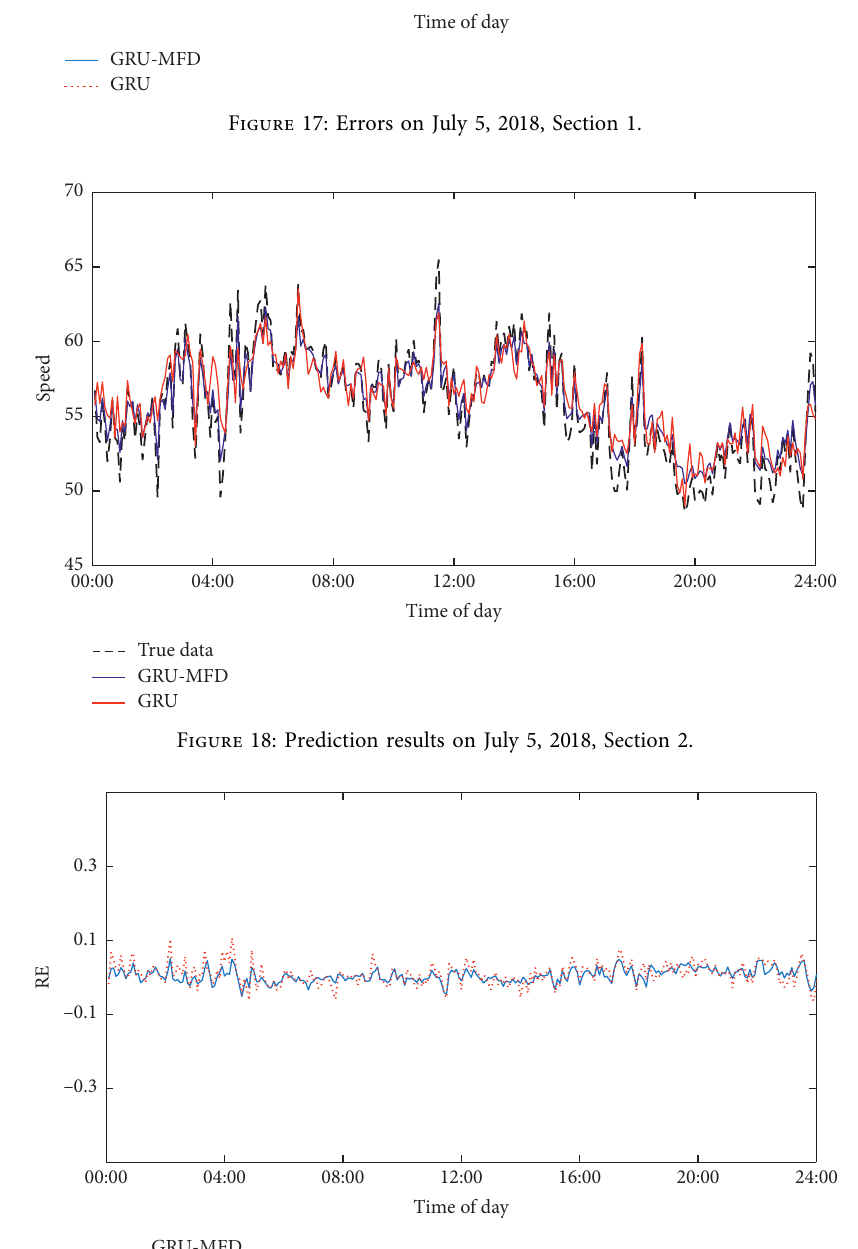
Figure 19: Errors on July 5, 2018, Section